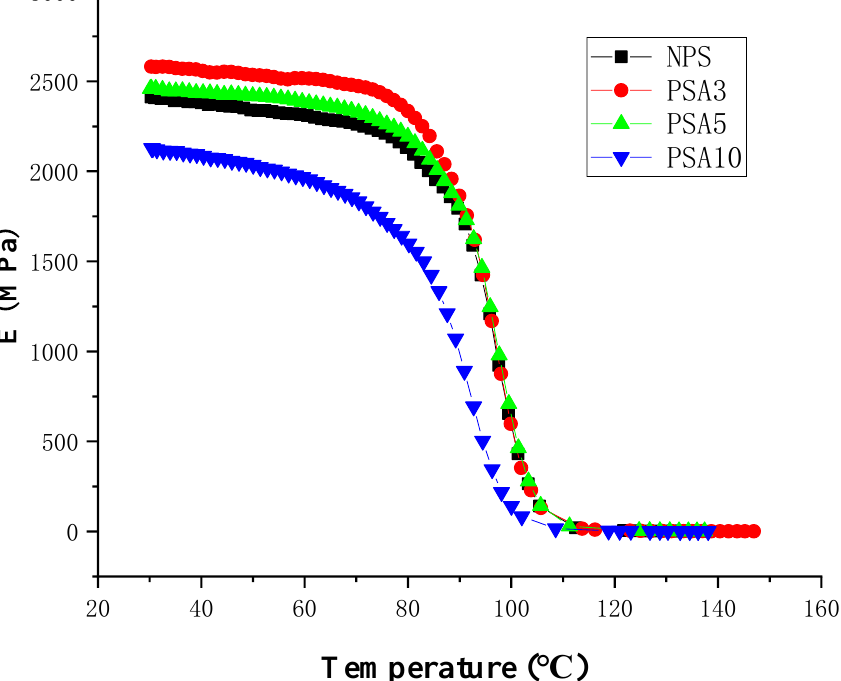
Figure 10. The measured complex moduli of Type I samples with respect to the temperature changes.